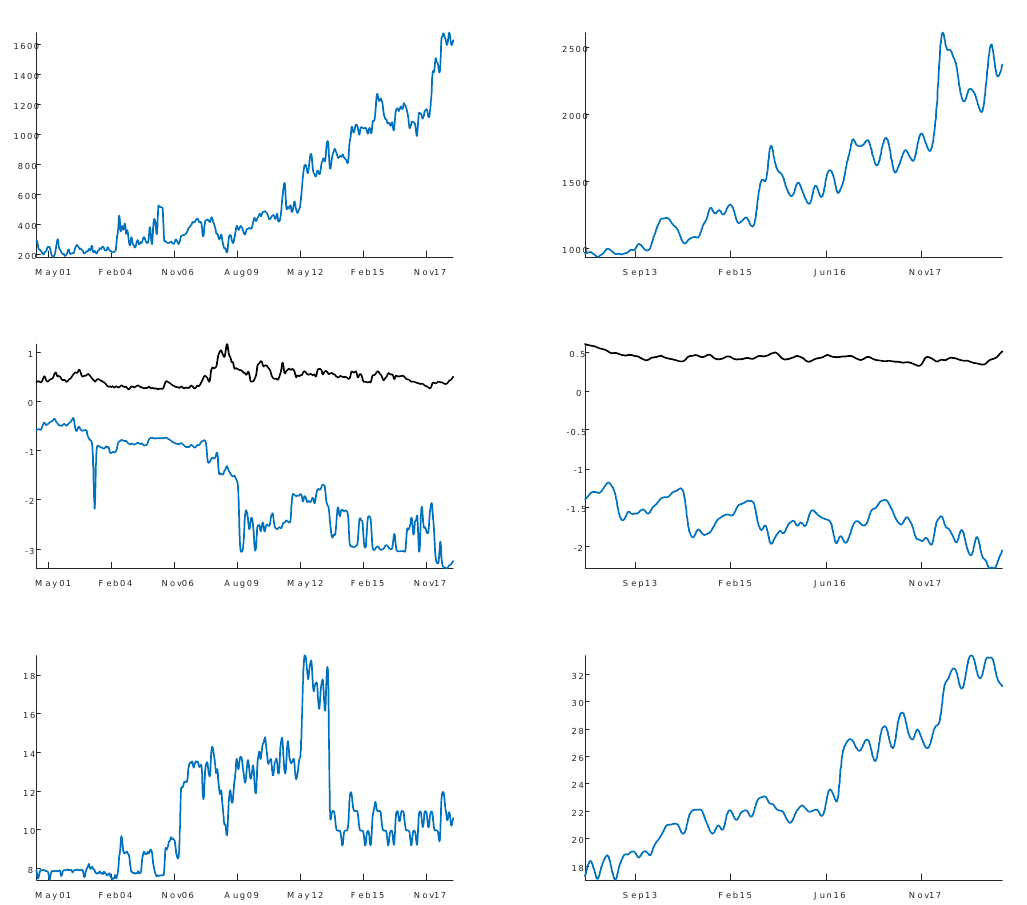
Figure 1. The left panel presents results for the SPX while the right panel presents comparable results for SPY . The time period for the SPX is 2001–2018 while for SPY it is 2013–2018. The top row is for the number of options traded. The middle row show the highest and lowest levels of moneyness measured by the log strike to forward ratio. The bottom row presents the number of maturities traded.